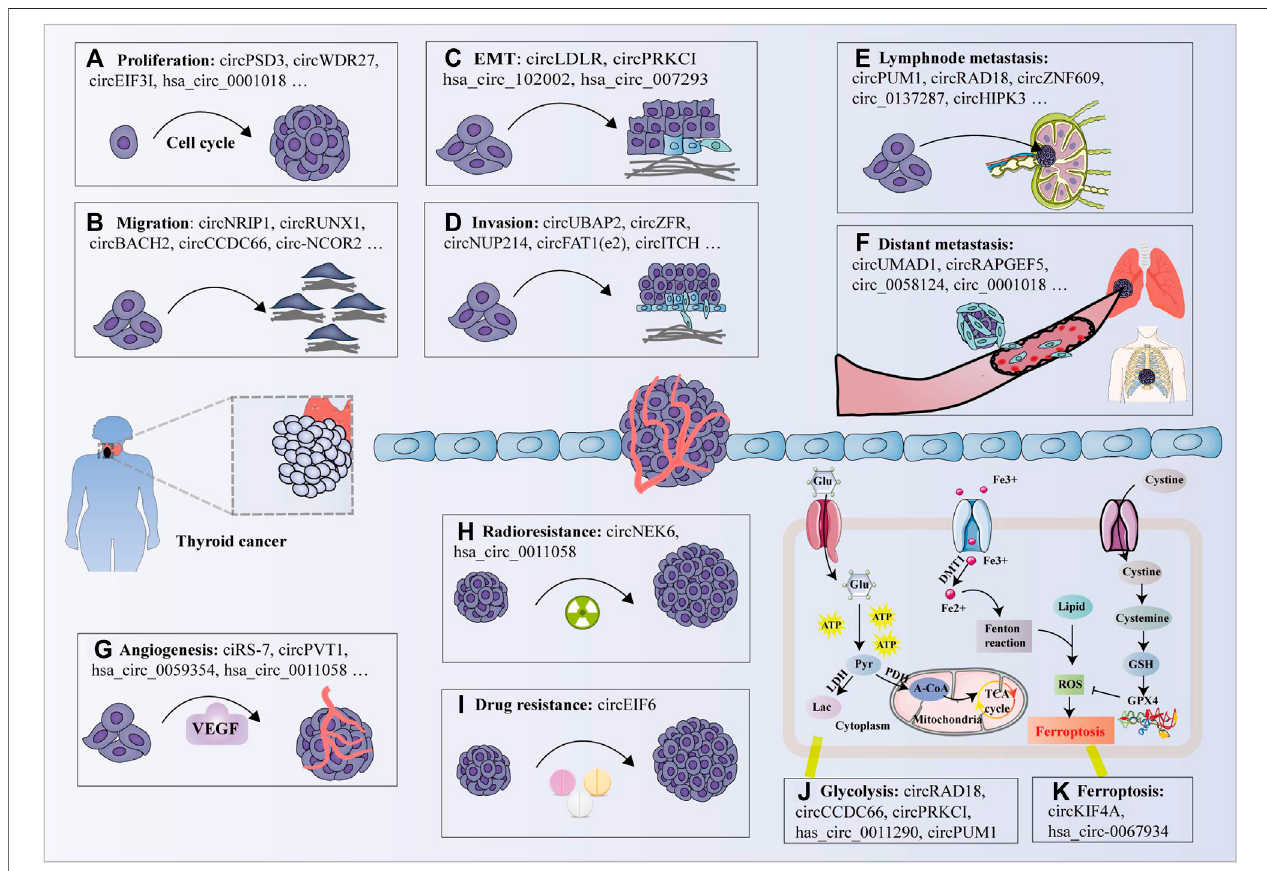
FIGURE3| BiologicalfunctionsofcircRNAsinthyroidcancer. (A) circRNAspromotecellproliferationbypromoting(e.g.,circPSD3)orinhibiting(e.g.,circITCH); (B) circRNAs promote cell migration by facilitating (e.g., circNRIP1) or inhibiting (e.g., hsa_circ_0007694); (C) circRNAs modulate the epithelial-mesenchymal transition (EMT) process by promoting (e.g., circLDLR); (D) Some circRNAs promote cell invasion (e.g., circZFR), while other circRNAs inhibit cell invasion (e.g., circNEURL4); (E) Several circRNAs are correlated with lymphnode metastasis (e.g., circPUM1); (F) A few circRNAs are associated with distant metastasis (e.g., circUMAD1); (G) Some circRNAs have been shown to promote tumor angiogenesis (e.g., ciRS-7) by modulating vascular endothelial growth factor A (VEGFA) expression; (H) Several circRNAs facilitate radioresistance in TC cells (e.g., circNEK6); (I) Individual circRNA promotes the drug-resistance of TC cells (e.g., circEIF6); (J) Certain circRNAs modulateglycolysis(e.g.,circRAD18);and (K) ferroptosis(e.g.,circKIF4A)inthyroidcancercells.Glu:glucose,ATP:adenosinetriphosphate,Pyr:pyruvate,Lac:lactate, LDH: lactate dehydrogenase, PDH: pyruvate dehydrogenase, A-CoA: acetyl-CoA, TCA cycle: tricarboxylic acid cycle, GSH: glutathione, ROS: reactive oxygen species, GPX4: glutathione peroxidase